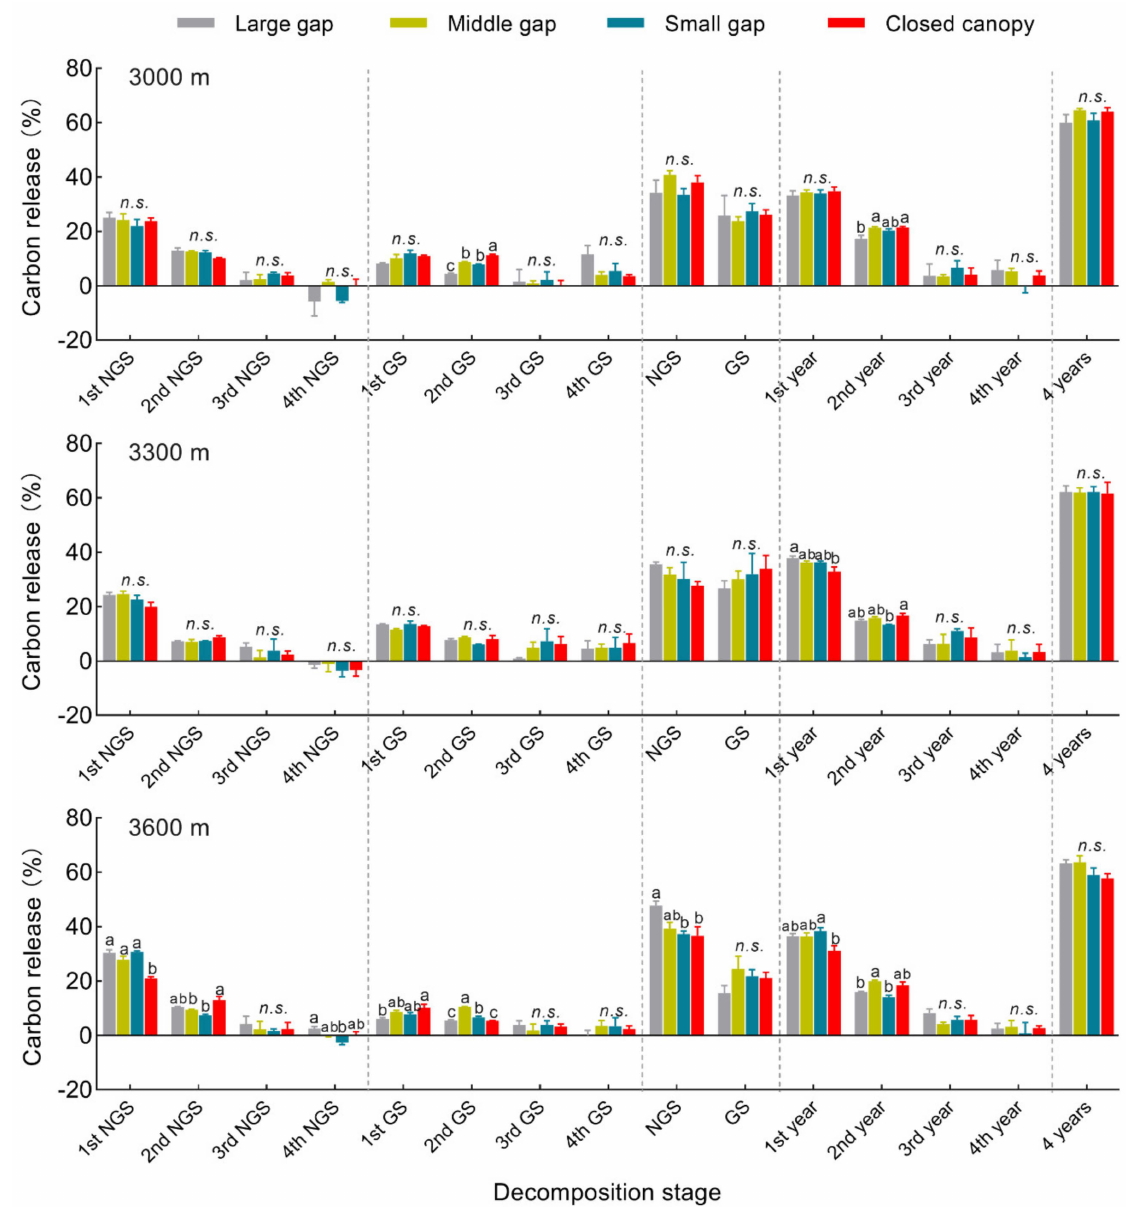
Figure 5. Carbon release percentage of A. faxoniana litter in forest gaps (large gap, middle gap, small gap, closed canopy) along an elevation gradient (3000, 3300, 3600 m) at different decomposition stages in a subalpine forest of southwestern China. Mean ± SE, n = 3. 1st NGS, non-growing season in the first decomposing year; 2nd NGS, non-growing season in the second decomposing year; 3rd NGS, non-growing season in the third decomposing year; 4th NGS, non-growing season in the fourth decomposing year; 1st GS, growing season in the first decomposing year; 2nd GS, growing season in the second decomposing year; 3rd GS, growing season in the third decomposing year; 4th GS, growing season in the fourth decomposing year; NGS, the non-growing seasons in the four decomposing years; GS, the growing seasons in the four decomposing years. Lowercase letters indicate significant differences among forest gaps ( p < 0.05), n.s . indicates no significant differences ( p >